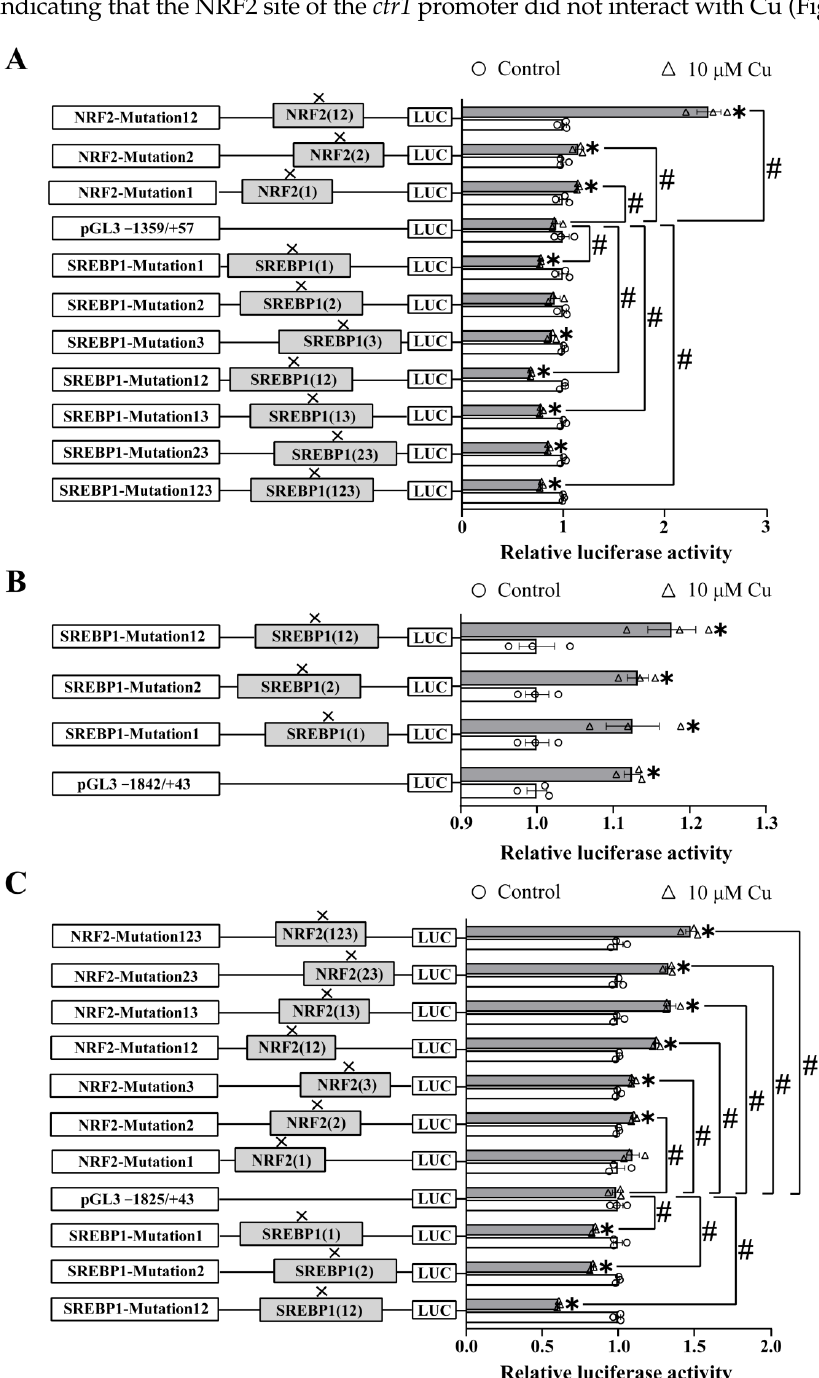
Figure 3. Assays of predicted NRF2 and SREBP1 binding sites of yellow catfish ctr1 , ctr2 and atox1 promoters after site-directed mutagenesis. ( A ) Site mutagenesis of NRF2 and SREBP1 on pGl3-ctr1-1359 vector. ( B ) Site mutagenesis of SREBP1 on pGl3-ctr2-1842 vector. ( C ) Site mutagenesis of NRF2 and SREBP1 on pGl3-atox1-1825 vector. Values mean the ratio of activities of Firefly to Renilla luciferase, normalized to the control. Results are presented as means ± SEM (n = 3). Asterisk (*) indicates significant differences between the Cu-treated group and the control in the same fragment ( p < 0.05); hash symbol (#) indicates significant differences in relative luciferase activities between the two fragments under the same treatment ( p <